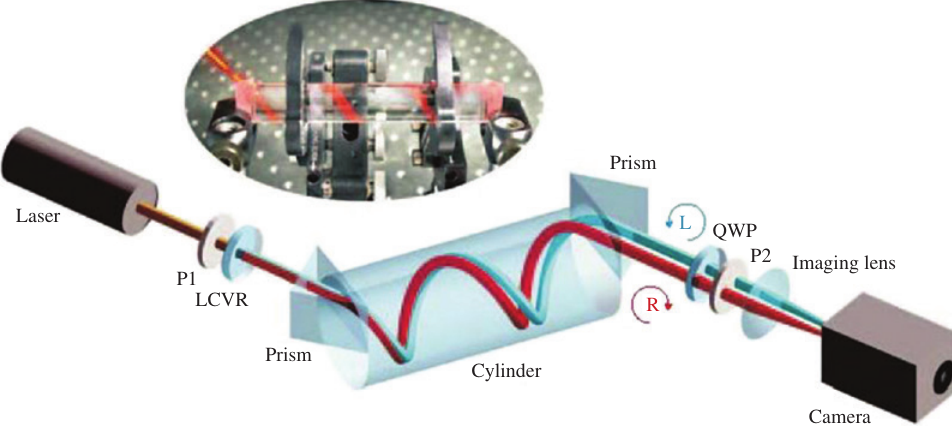
Figure 8: A laser beam enters the glass cylinder at a grazing angle through the input prism, coils along the cylinder surface, and leaves it by means of the output prism. The liquid-crystal variable retarder (LCVR) is used for generating and switching between the circularly polarizations, whereas the quarter-wave plate (QWP) and polarizer P2 are intended for measurement of the Stokes parameters. The inset shows a real picture of the spiral light beam inside the cylinder. Adapted from Ref. [15].